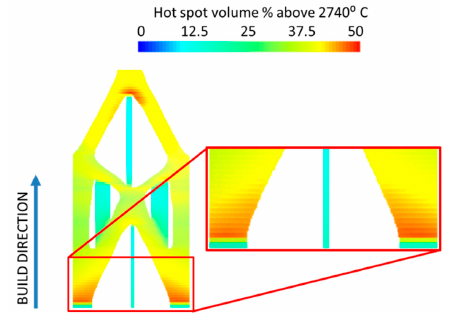
Figure 6. Hot spot contour plot from a process simulation of the optimized geometry. The inset shows the region with the highest thermal accumulations in terms of the percentage of finite element volume.